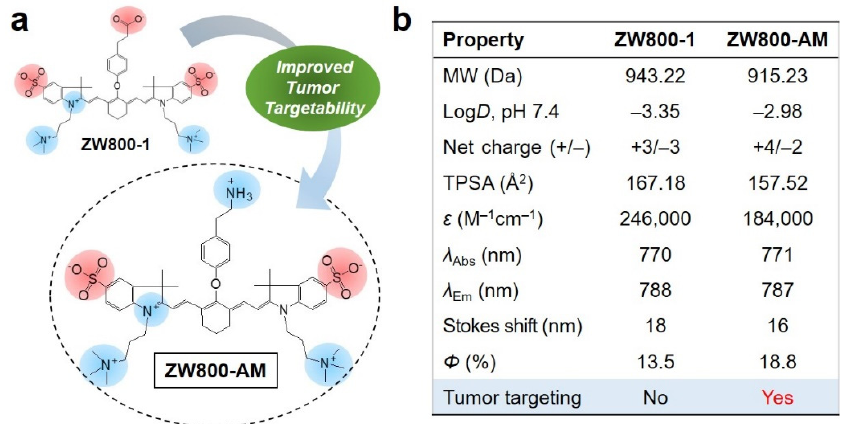
Figure 1. ( a ) Chemical structures of ZW800-1 and ZW800-AM NIR fluorophores, and ( b ) their